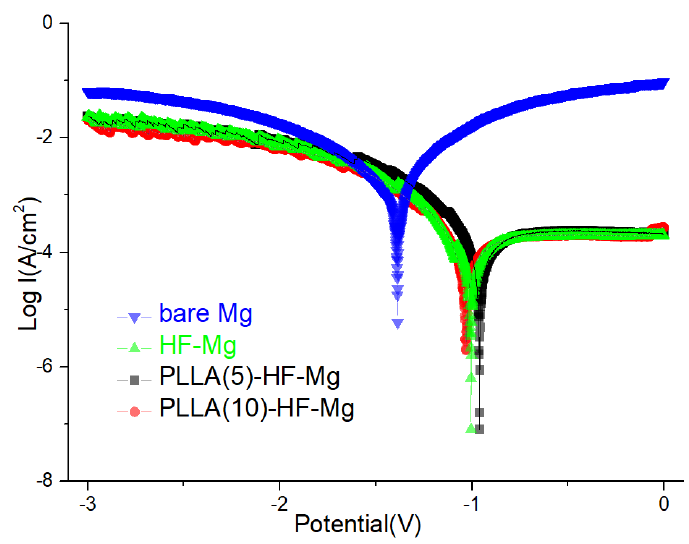
Figure 7. PDP curves of coated and bare Mg alloy samples in SBF. Table 2. Corrosion current density of coated and bare Mg alloy samples (unit: µ A/cm 2 ). Samples